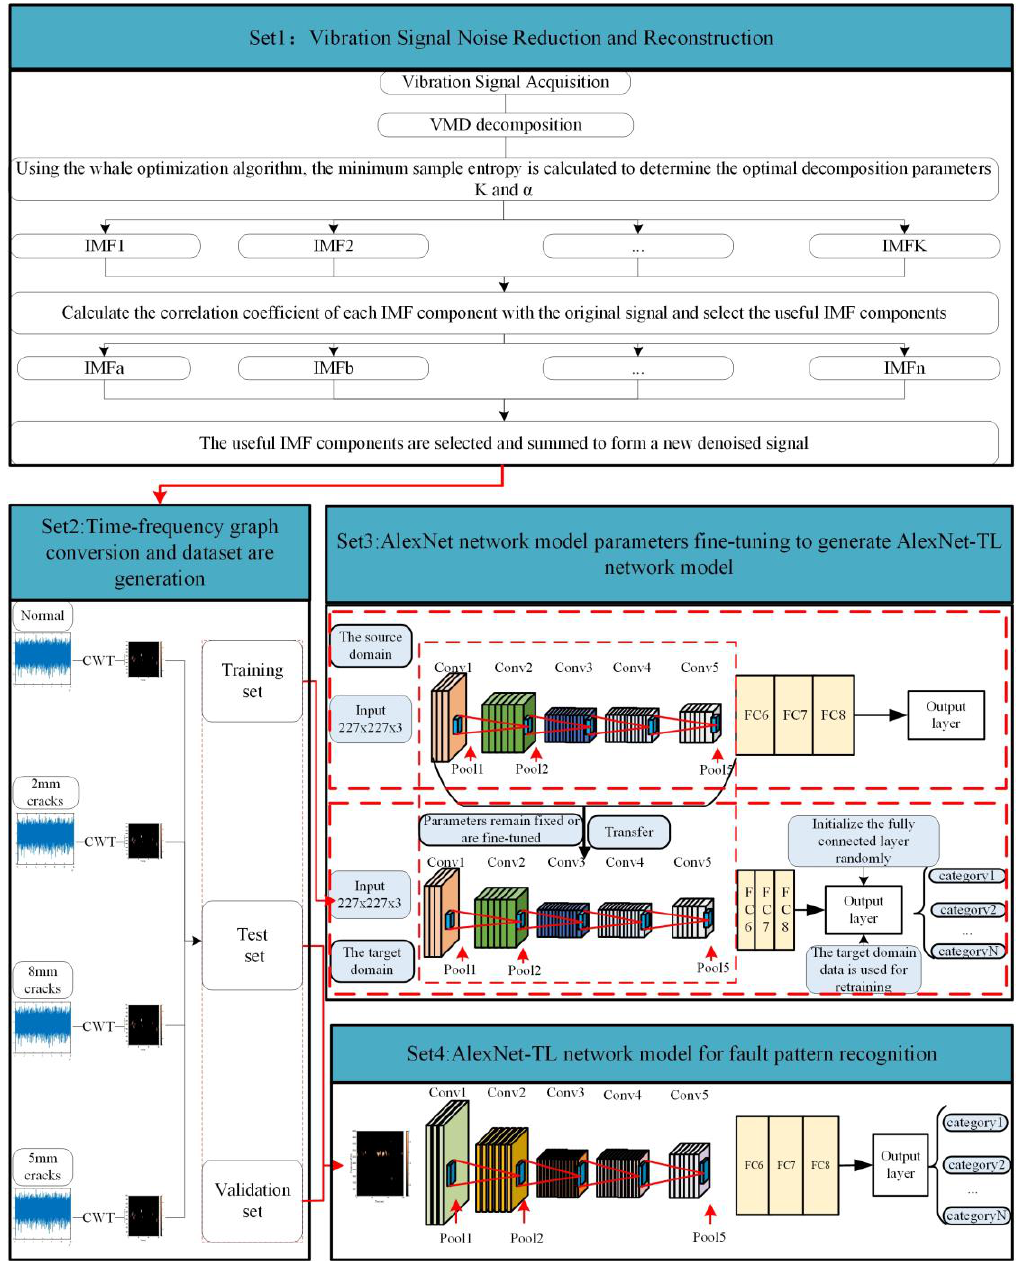
Figure 7. Flowchart for gearbox fault diagnosis based on WOA-VMD and deep transfer